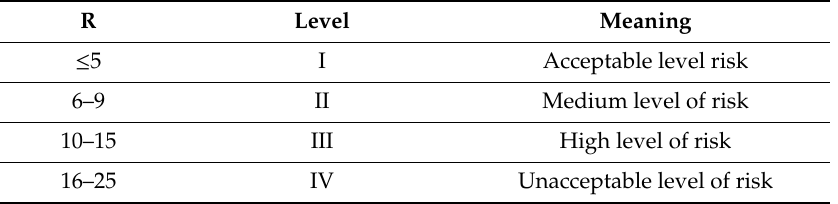
Table 2. Levels of the human error risk